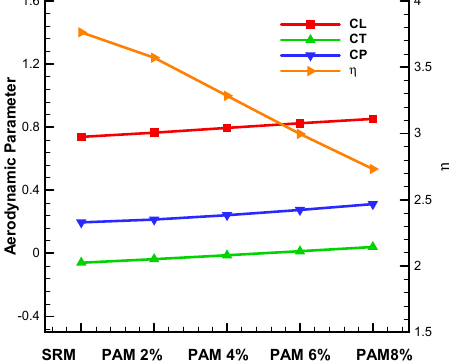
Figure 14. Time-averaged aerodynamic parameters for di ff erent start times of stroke